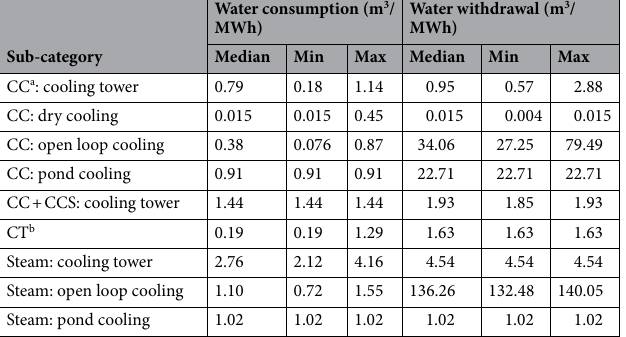
Table 10. Gas-fired power plant’s water withdrawal and consumption data 69 . a Combined cycle; b combustion